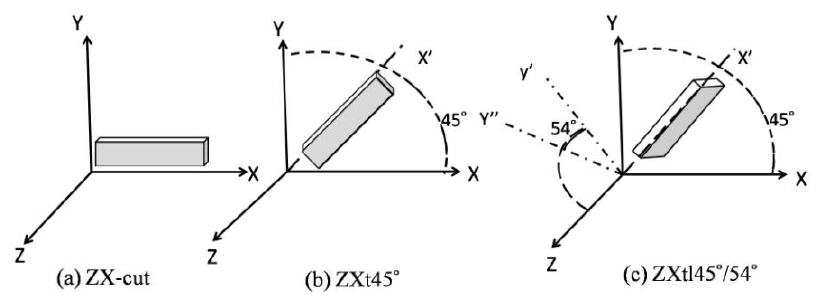
Figure 4. The coordinate rotation for ZXtl 45°/54°-crystal cut.